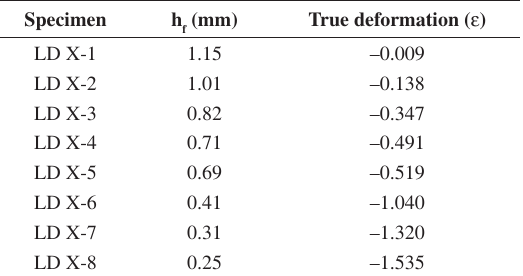
Table 2. Specimens produced by cold rolling.